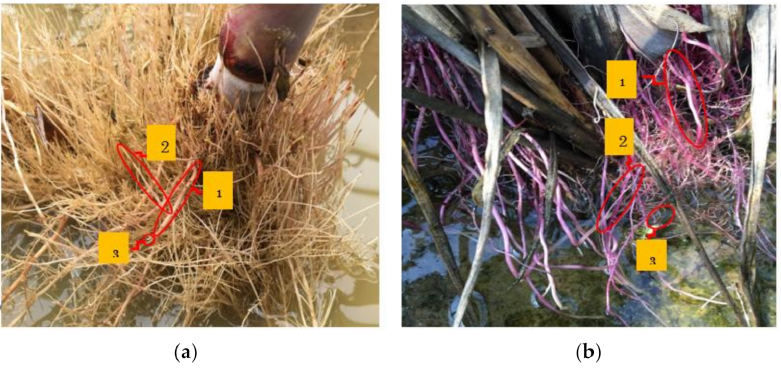
Figure 2. The adventitious root of the KK3 ( a ) and K93-219 ( b ) cultivars separated into 3 types: primary (1), secondary (2), and roots initiated from secondary adventitious roots